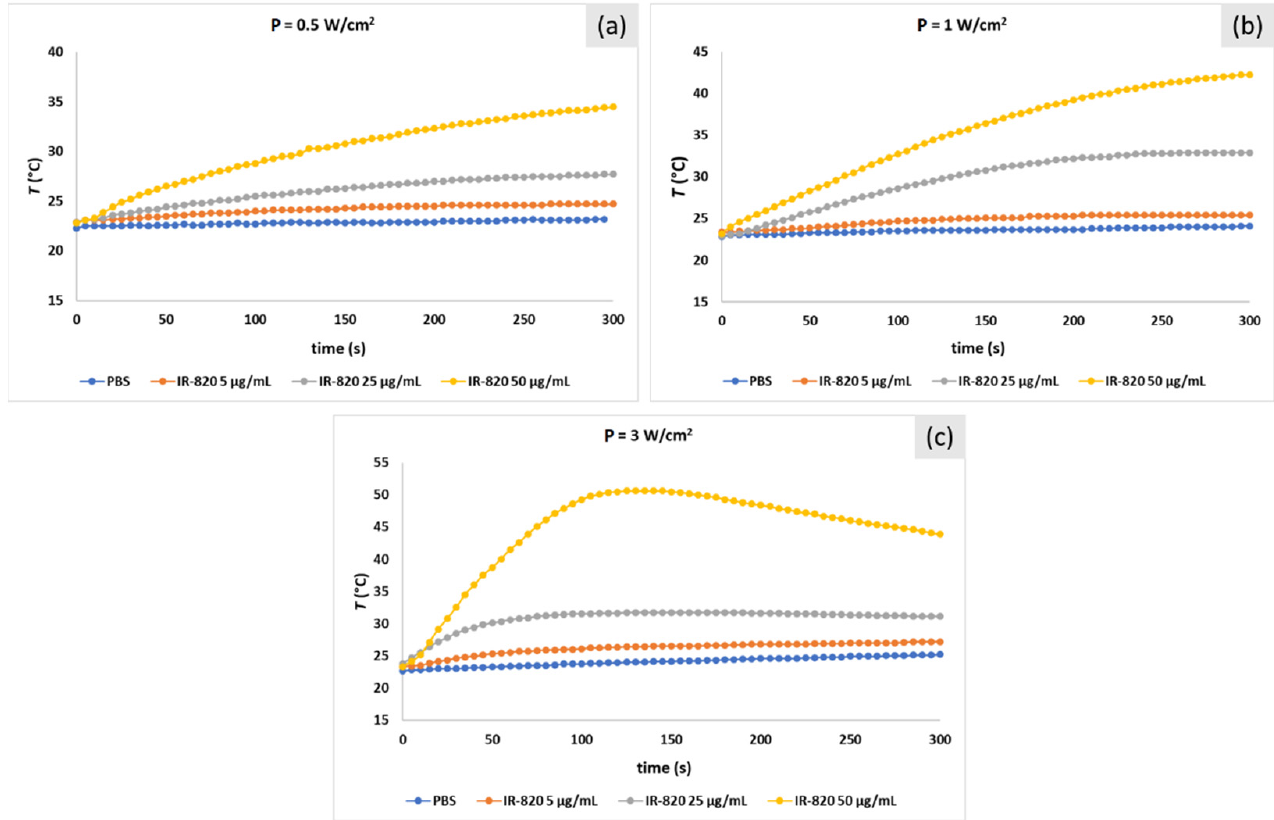
Figure 5. Temperature profiles of IR-820 solutions with three different concentrations (5, 25, and 50 µ g/mL) in PBS irradiated with 808 nm laser at laser power ( a ) P = 0.5 W/cm 2 , ( b ) P = 1 W/cm 2 , and ( c ) P = 3 W/cm 2 . PBS solution was irradiated as a control.